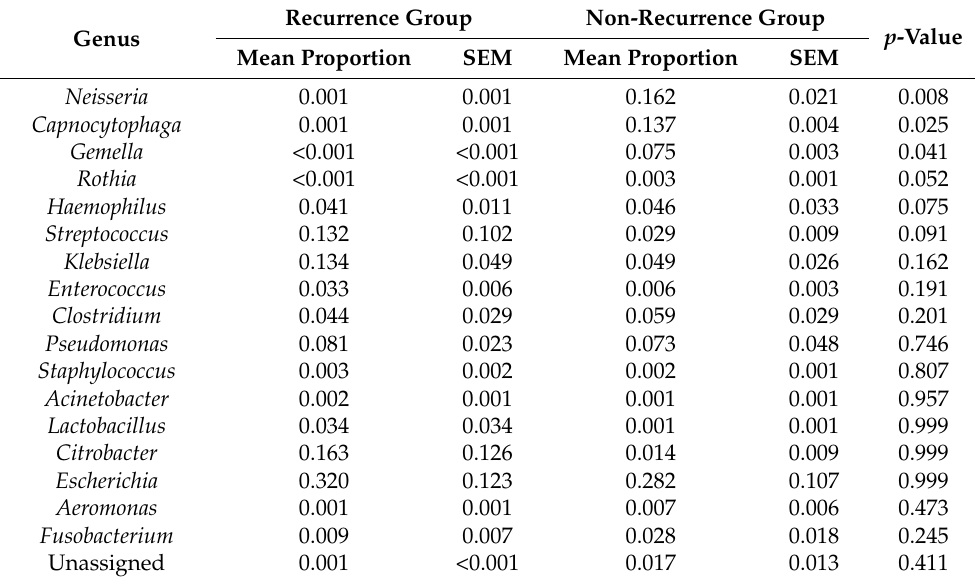
Table 3. List and relative proportion of genus identified by next-generation sequencing.